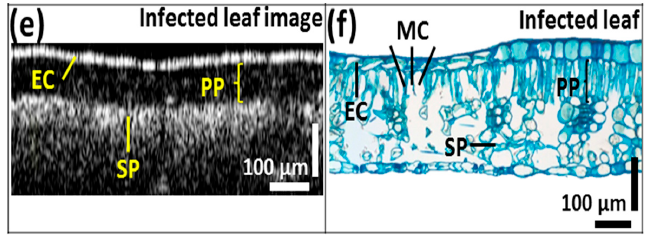
Figure 5. Comparison between ( a ), ( c ), and ( e ) OCT images; ( b ), ( d ), and ( f ) histological sectioning images of three leaf categories. EC—epidermal cells, PP—palisade parenchyma, SP—spongy parenchyma, MC—mycelium cells.